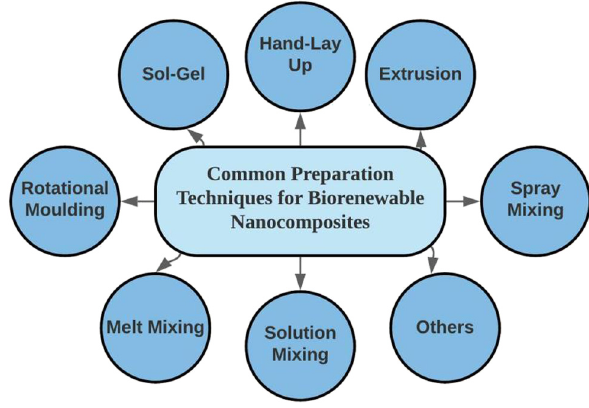
Figure 3: Various preparation methods employed for the fabrication of biorenewable